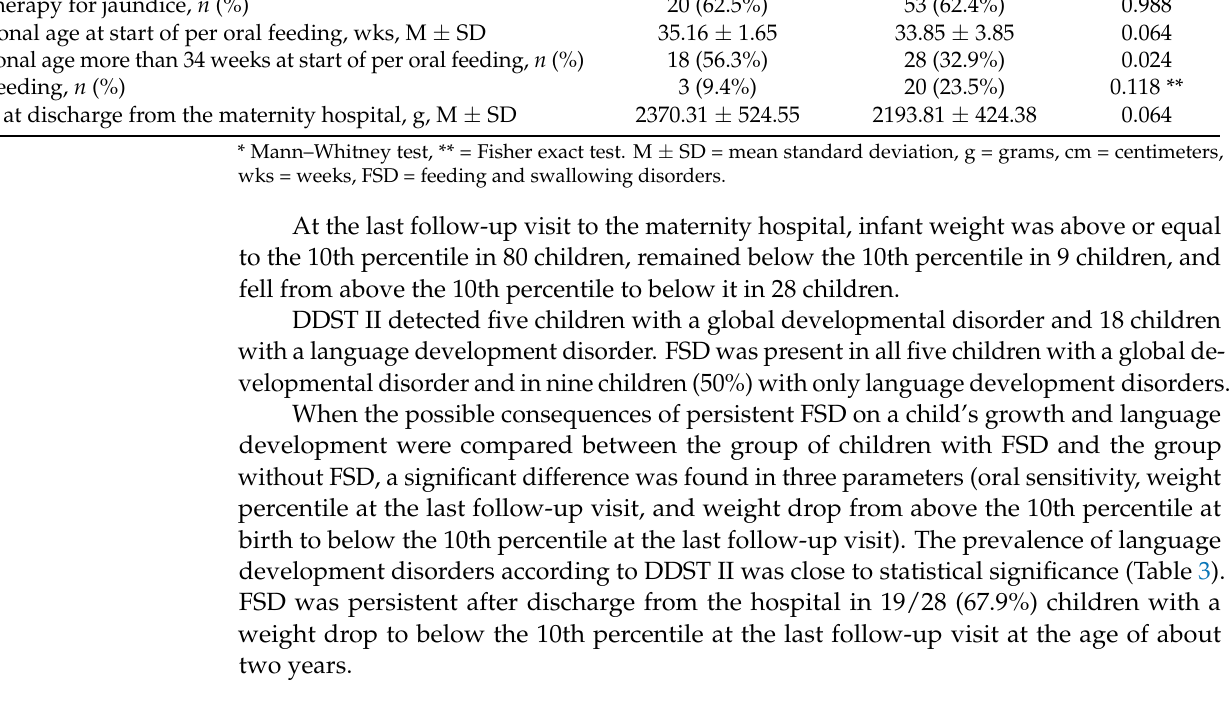
Table 3. Comparison of preterm children by feeding and swallowing disorders (FSD) following